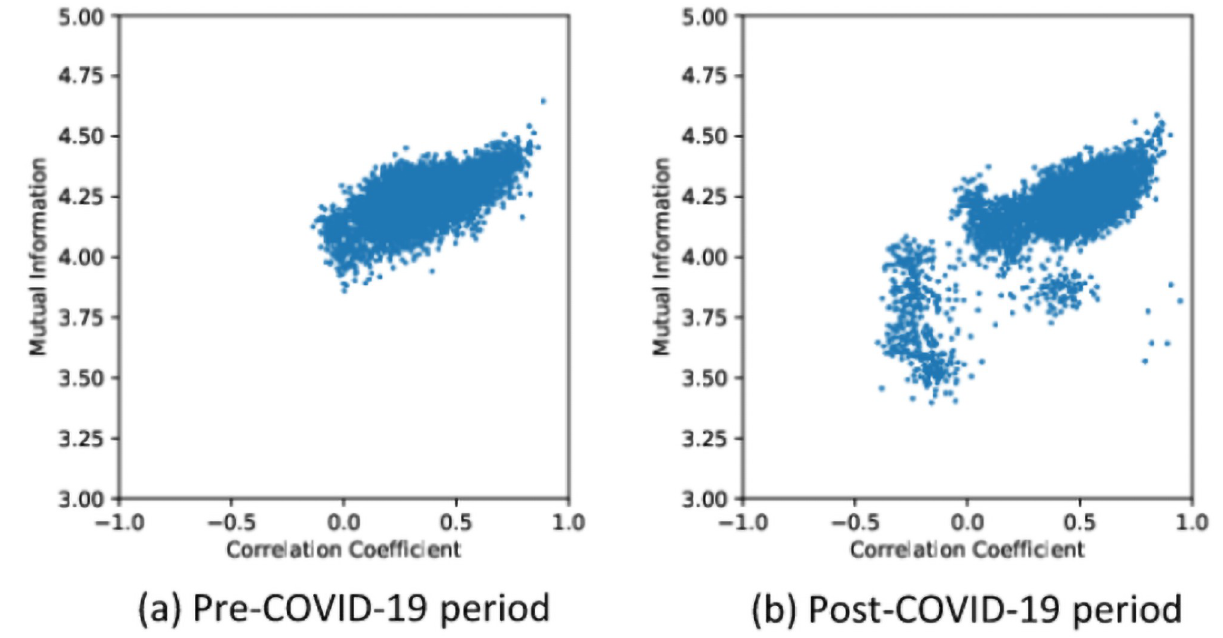
Fig 4. Comparison of correlation coefficient and mutual information over a given period.